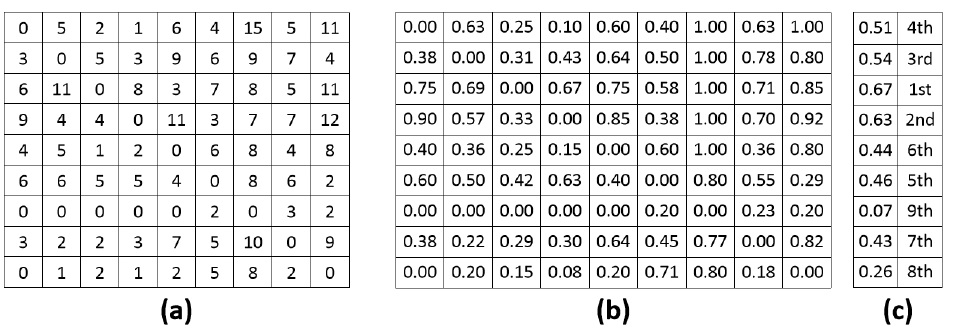
Figure 13. IQA experiment based on human preference with and without reference.